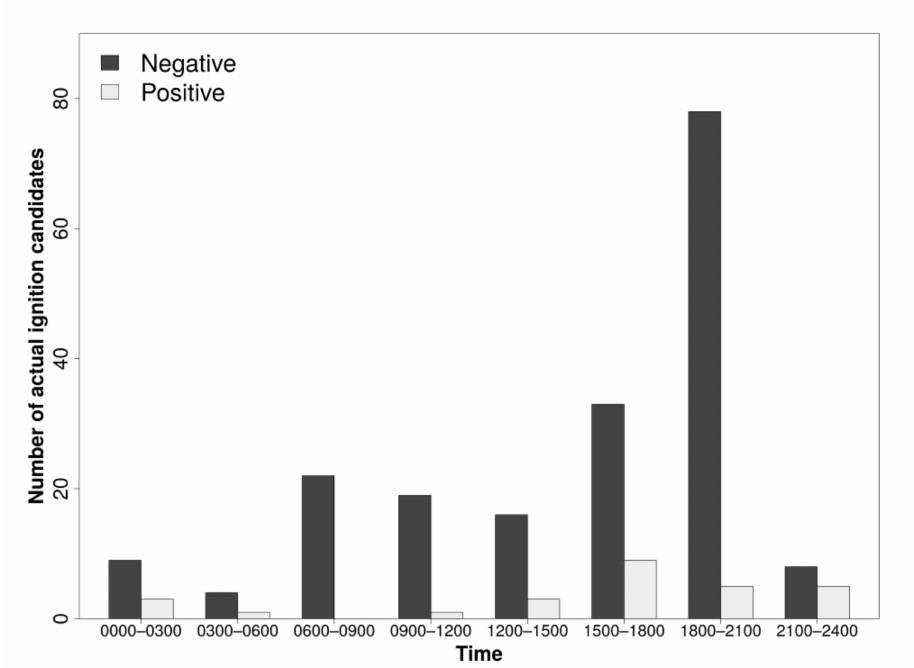
Figure 6. Diurnal pattern of actual ignition candidates classified with negative and positive